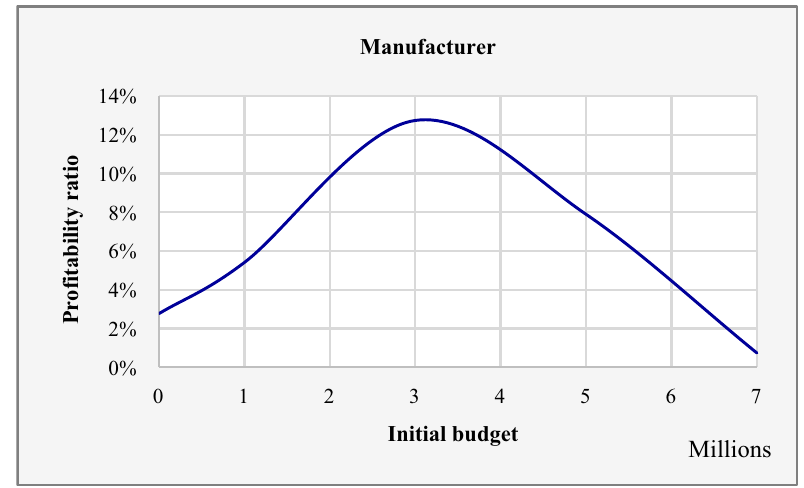
Fig. 15 The result of analyzing the sensitivity of the manufacturer’s profitability ratio to the changes in the initial budget